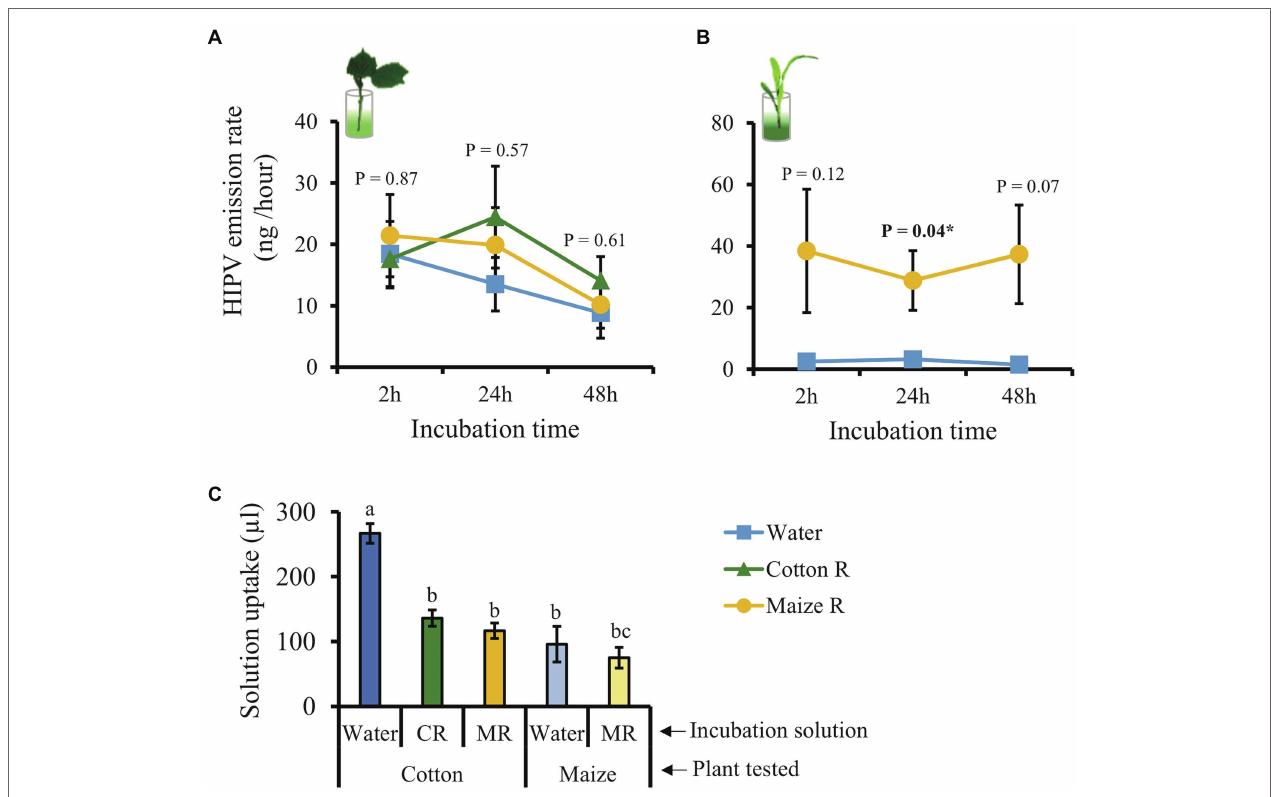
FIGURE 5 | Incubation in caterpillar regurgitant does not induce volatile emissions in cotton plants. (A) Total emission of volatiles released by cotton plants incubated in water (blue line), regurgitant of cotton–fed S. exigua (green line) and regurgitant of maize–fed S. exigua (yellow line) after 2, 24, and 48 h ( n = 4–6). (B) Total emission of volatiles released by maize plants ( n = 4) incubated in water (blue line) and regurgitant from maize–fed S. exigua (yellow line) after 2, 24, and 48 h. (C) Mean quantity of solution taken up by either cotton or maize plants over 48 h. Lines and bars represent the average (±SE). Different letters indicate significant differences among treatments ( p < 0.05). p values are given for treatments [GLM (family, Gaussian)] followed by pairwise comparisons of LSMeans . *** p < 0.001 and * p < 0.05.